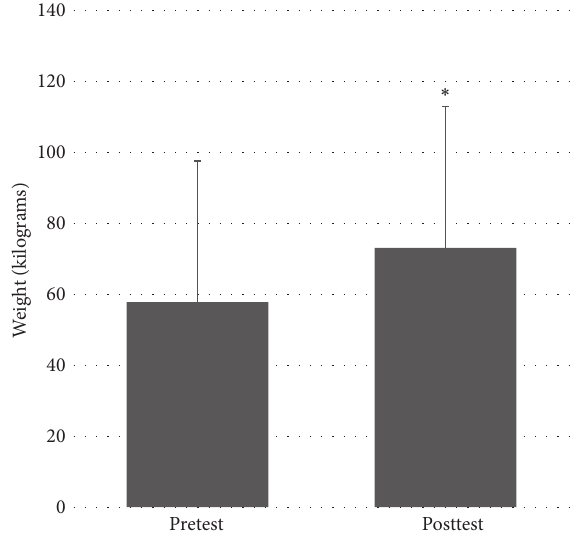
Figure 2: Pretest and posttest values for left leg 1RM. ∗ denotes statistically significant difference at 𝑃 < 0.05